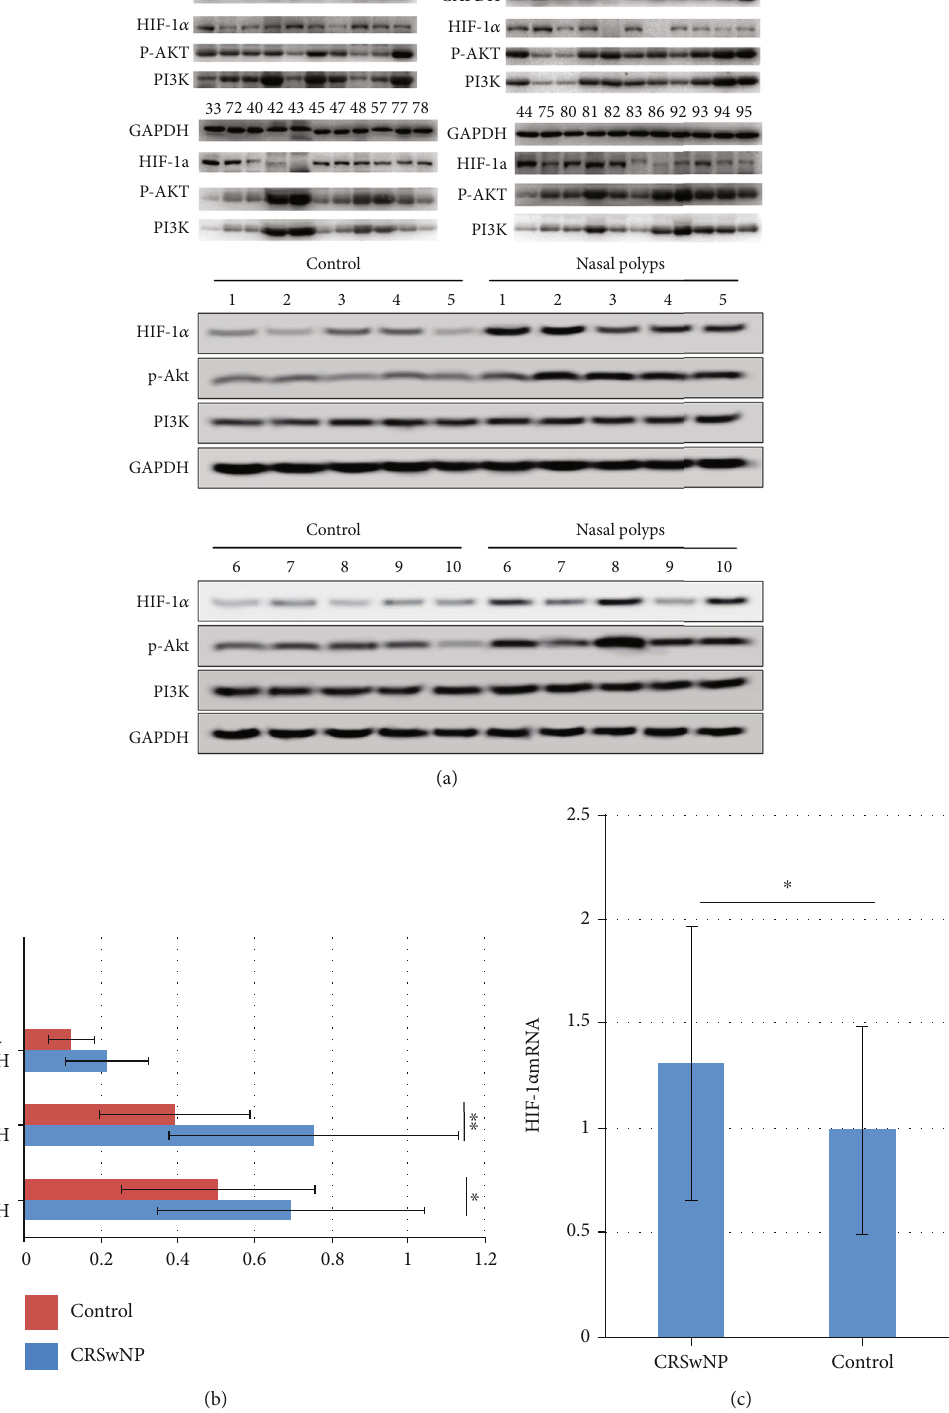
Figure 2: The activity of the PI3K/Akt/HIF-1 α pathway in nasal polyps. (a) The protein levels of HIF-1 α , p-Akt, and PI3K were detected by the WB method. Among them, 27, 33, 44, 72, 75, 81, 84, 88, and control 1-10 were the control groups, and the rest were the experimental groups. (b) The protein levels of HIF-1 α , p-Akt, and PI3K in di ff erent groups. Among them, p-Akt and PI3K protein levels in the polyp group were signi fi cantly increased, compared with the control group. P < 0 : 001 and P = 0 : 008 . The HIF-1 α protein level was not signi fi cantly di ff erent from that observed in control tissues. P = 0 : 242 . (c) The HIF-1 α mRNA expression level in nasal polyp tissues of CRSwNP patients was signi fi cantly higher than that in the control group. P = 0 : 012 . ∗ P < 0 : 05 , ∗∗ P < 0 : 001